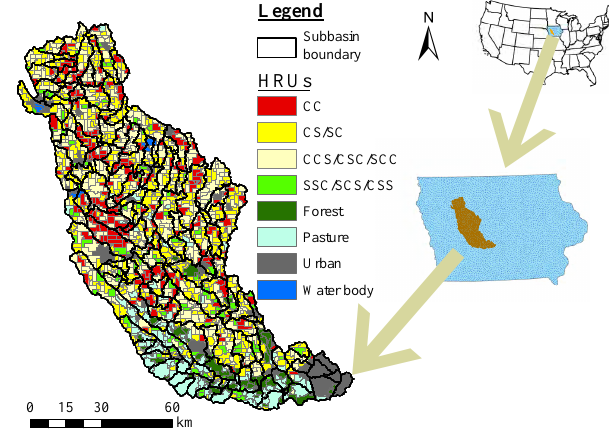
Figure 1. The RRW with its historical (baseline) land use (CC is continuous corn rotation, CS/SC is corn–soybeans rotation, CCS/CSC/SCC is 2 years of corn and 1 year of soybeans in 3-year rotation, SSC/SCS/CSS is 2 years of soybeans and 1 year of corn in 3-year